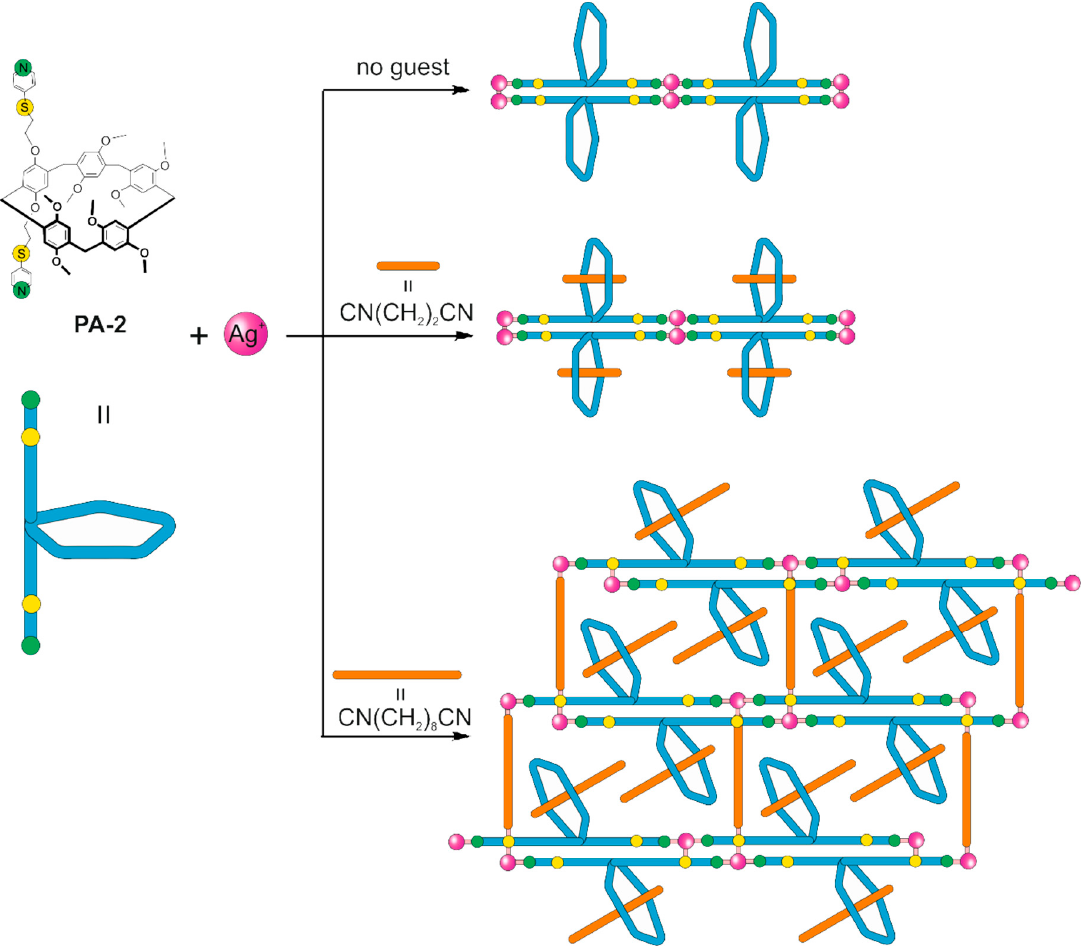
Figure 10. Cartoon representation of molecular architectures obtained by self-assembly of pillar[5]arene PA-2 , silver ions and G1 and G2 guest molecules.